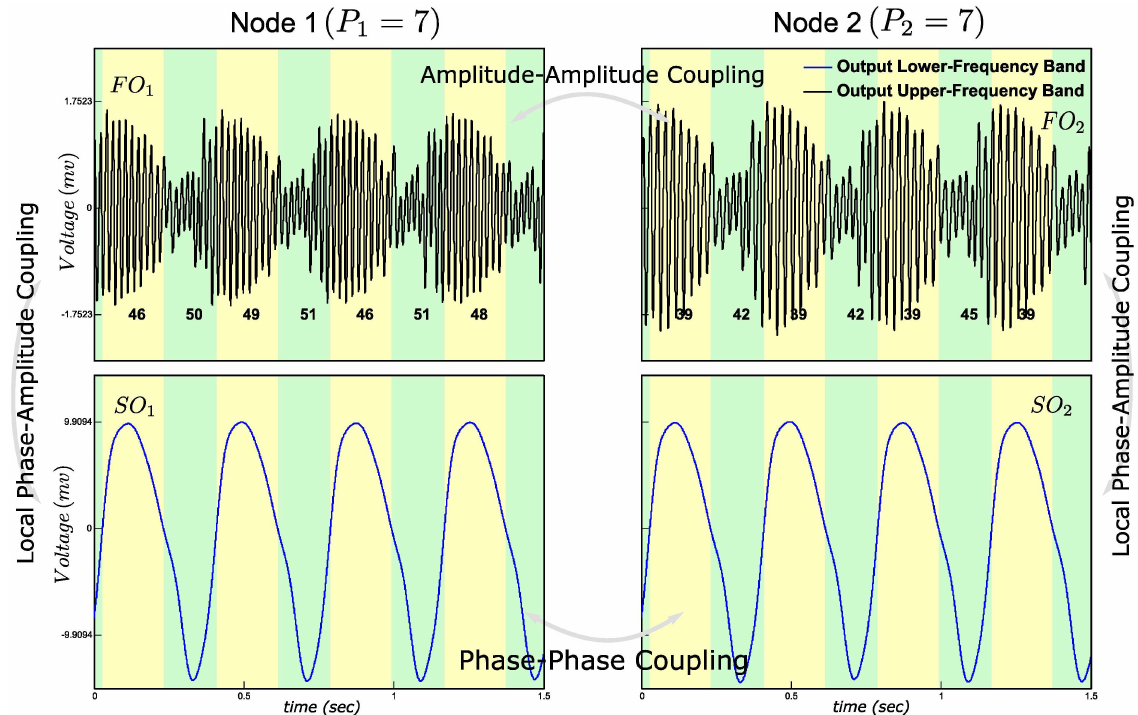
Fig 5. Amplitude-Amplitude Coupling (AAC) simulation. The instantaneous amplitudeof FO 1 and FO 2 correlatewith the synchronized SO 1 and SO 2 . Integers below the FO time waves indicateaveragenumberof zero crossings of FOs.